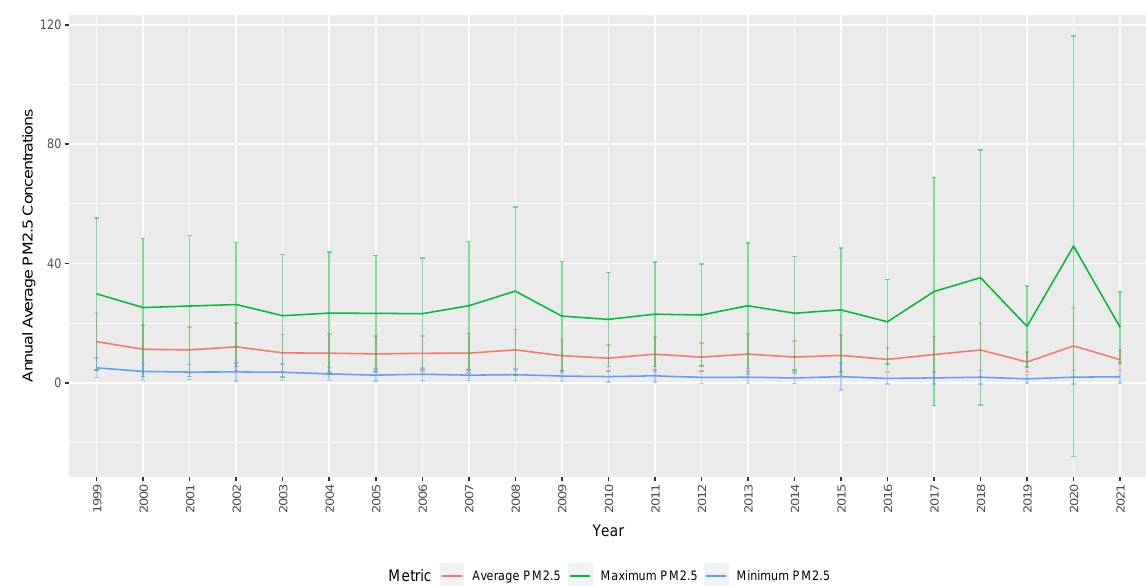
Figure 1. Average PM2.5 in California.